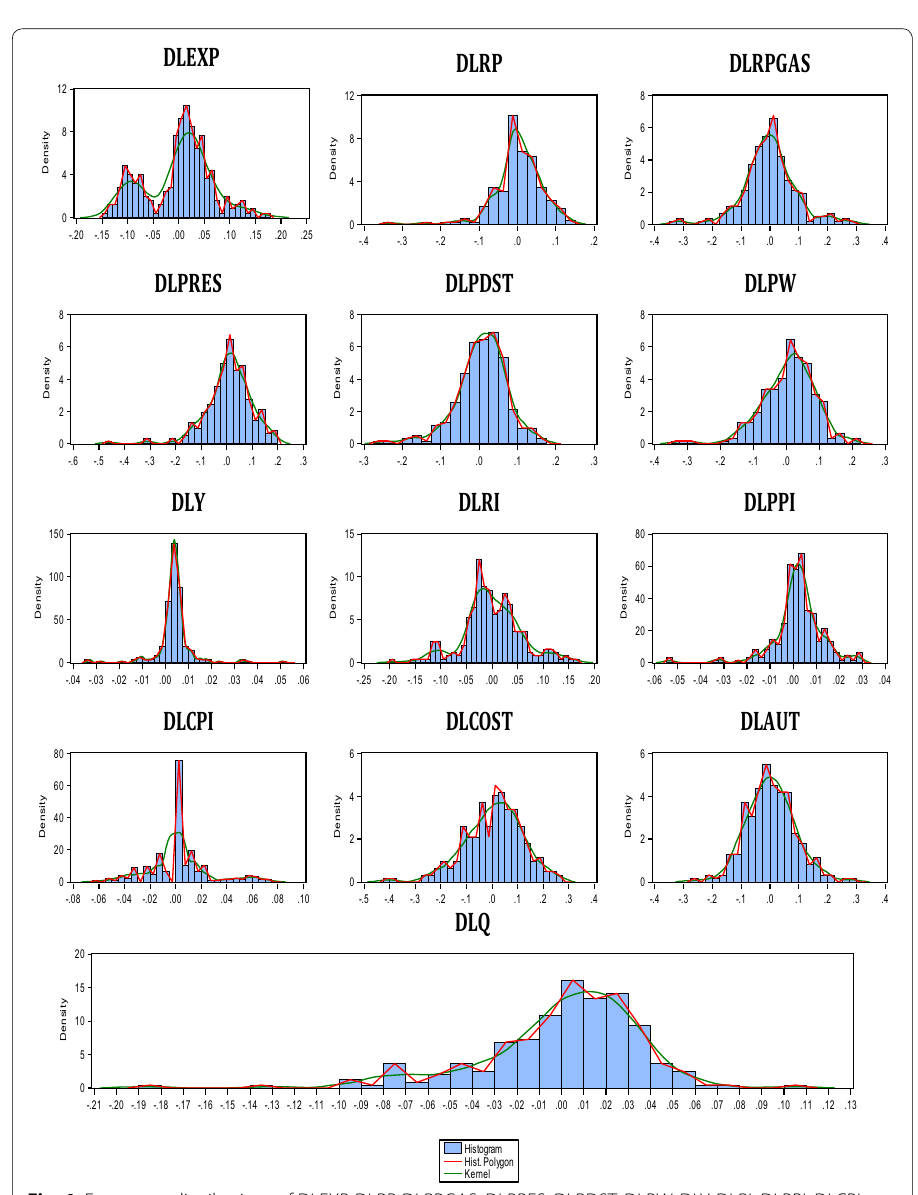
Fig. 4 Frequency distributions of DLEXP, DLRP, DLRPGAS, DLPRES, DLPDST, DLPW, DLY, DLRI, DLPPI, DLCPI, DLCOST, DLAUT and DLQ in the